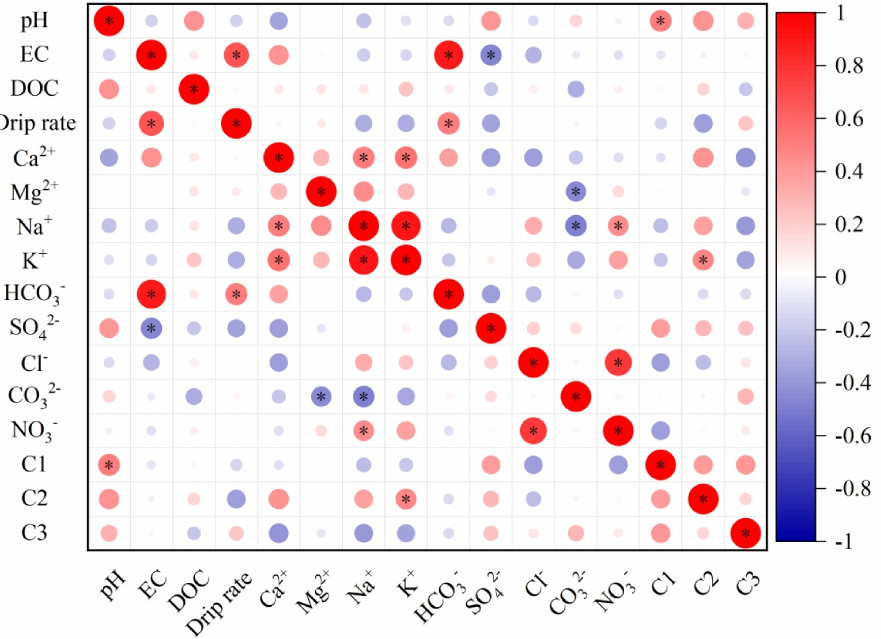
Figure 8. Heat map of the correlation between hydrochemistry and fluorescence components in the drip water of Daxiao Cave (* p ≤